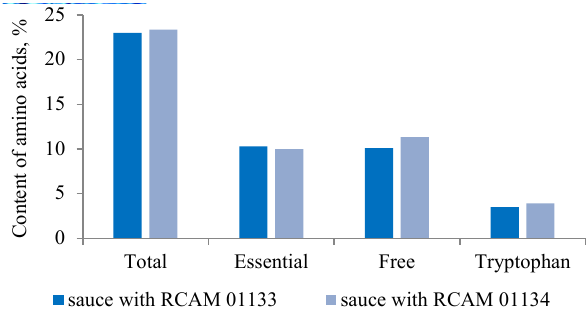
Figure 4 Contents of amino acids in fermented soy sauces with Aspergillus